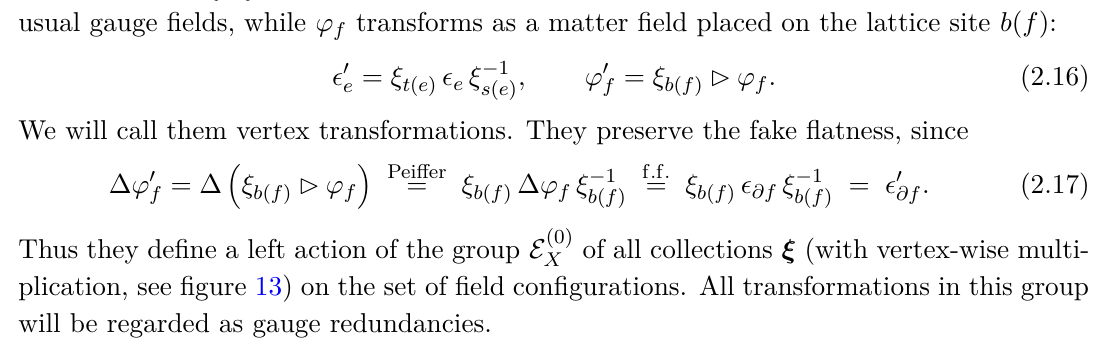
Figure 13 . Composition rule for vertex transformations: { ξ v } followed by { ξ 0 { ξ 0 ξ v } v